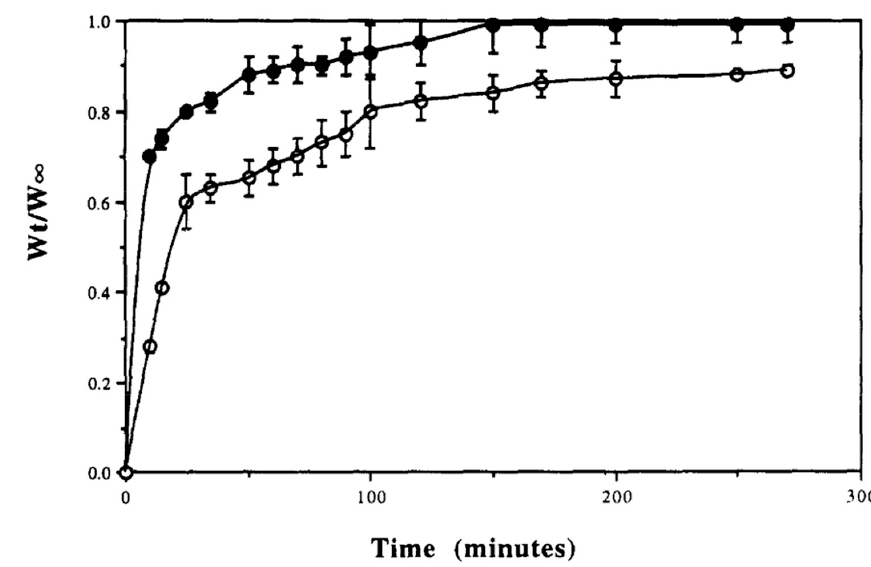
Figure 4. Swelling kinetics of polyNIPAAm hydrogels prepared at above (filled circles) and below (open circles) the lower critical solution temperature (LCST) [106]. Reproduced from [106] with permission. Copyright 1995 Elsevier.